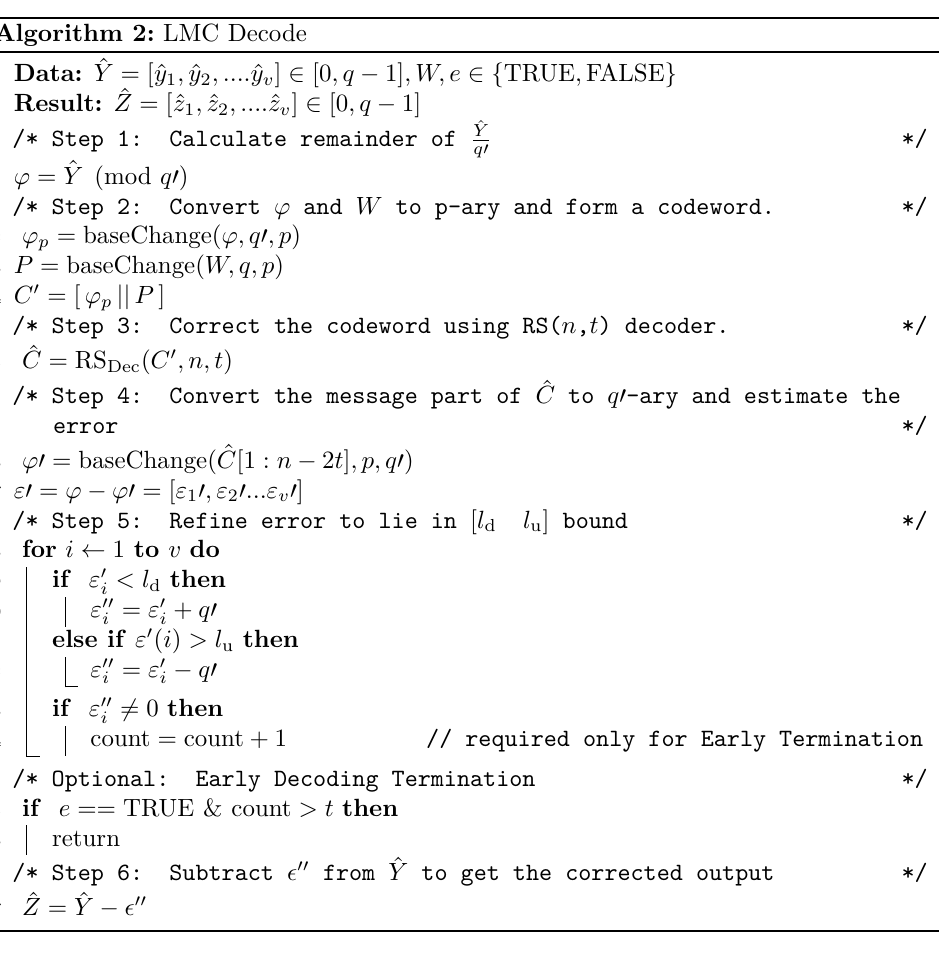
Algorithm 2: LMC Decode